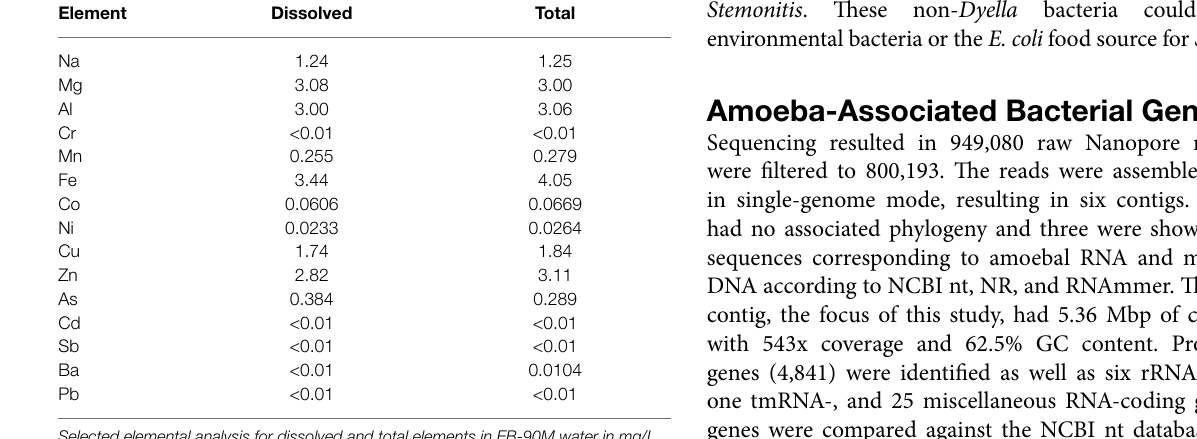
TABLE 1 | Chemical composition of EB-90M water. Element